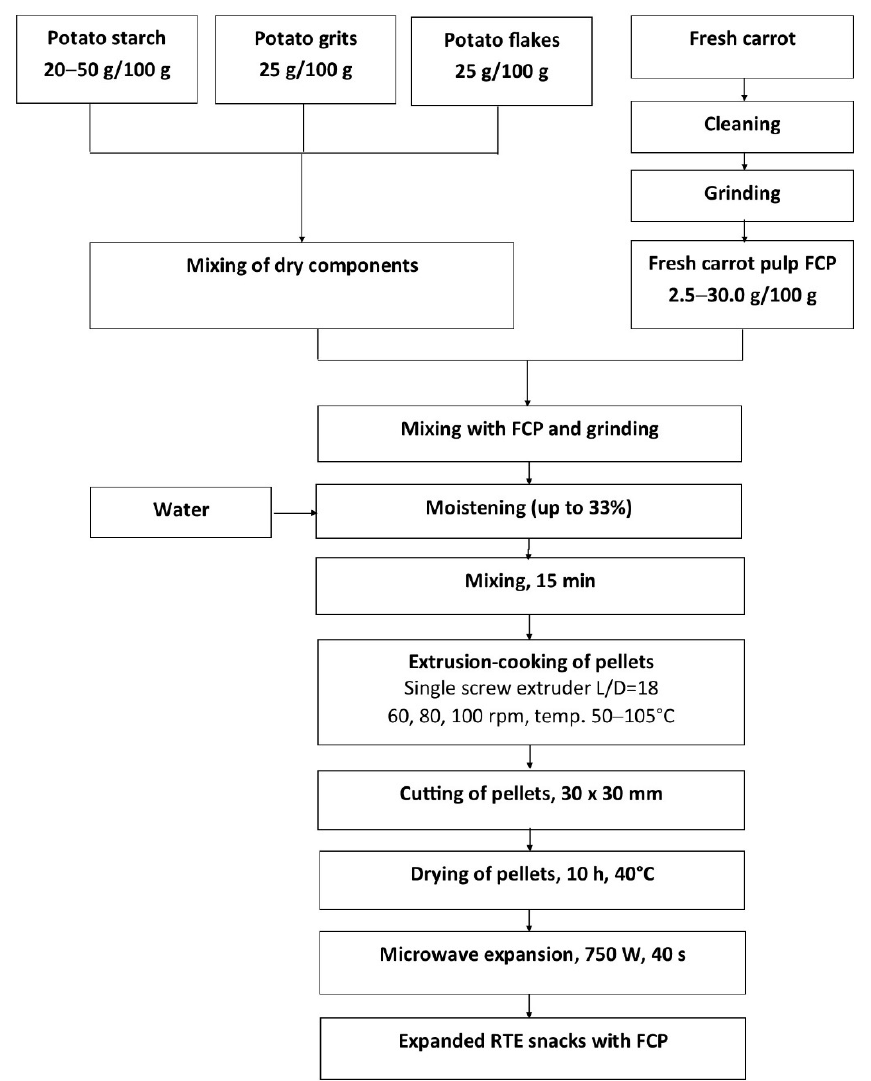
Figure 1. Diagram of the production process of pellets and snacks.